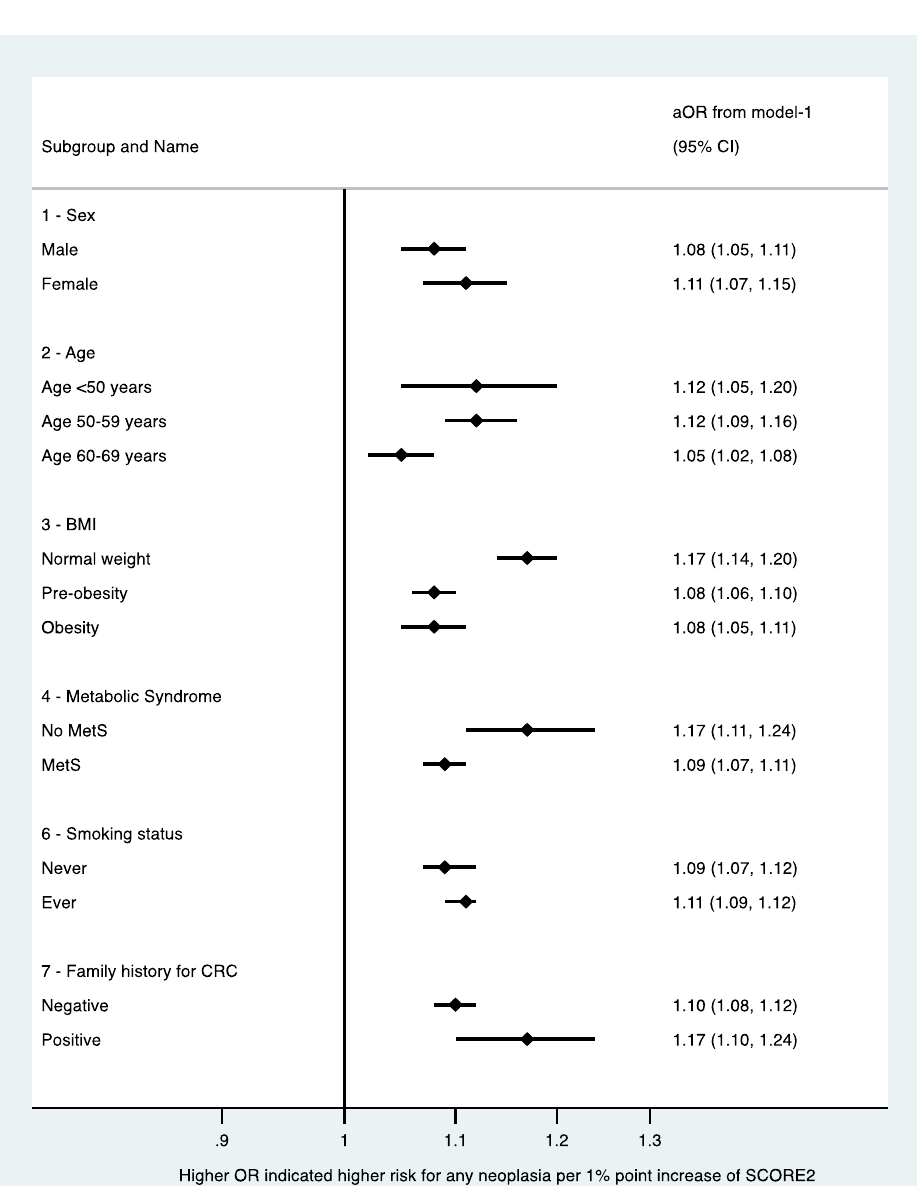
Figure 3. Sensitivity analyses stratifying the presence of the primary endpoint (any colorectal neoplasia) according to patient-specific baseline characteristics (stratified for sex, age (in categories), BMI (in categories according to the World Health Organization), smoking status, metabolic syndrome, and positive family history). For the sensitivity analyses, model-1 was fitted with SCORE2 as continuous variable as independent variable and any colorectal neoplasia as dependent variable in the strata. Abbreviations: BMI: body mass index; CI: confidence interval; and OR: odds ratio.